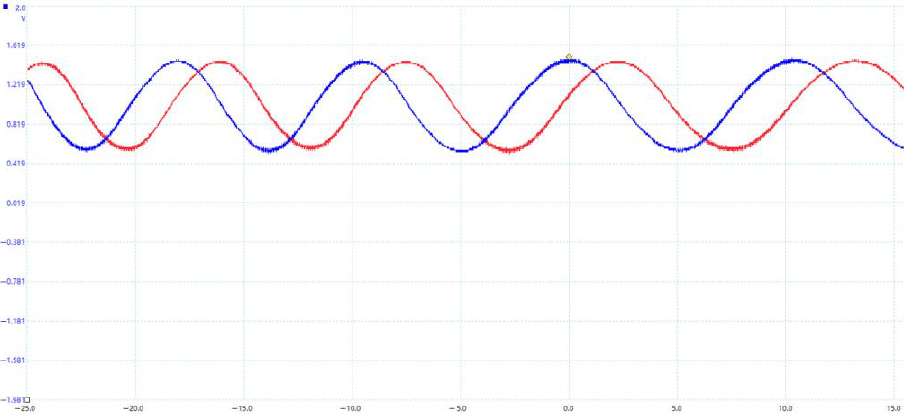
Figure 19. The oscilloscope collects the output of the magnetic encoder when the motor is rotating.